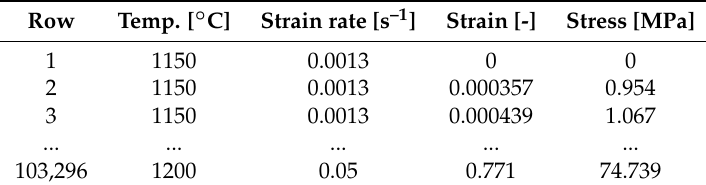
Table 3. Dataset used for training the ANNs to predict the entire course of the flow curves for TNM-B1, with the first three rows and the last row shown. Training inputs; temperature, strain rate and strain. Target output; flow stress.